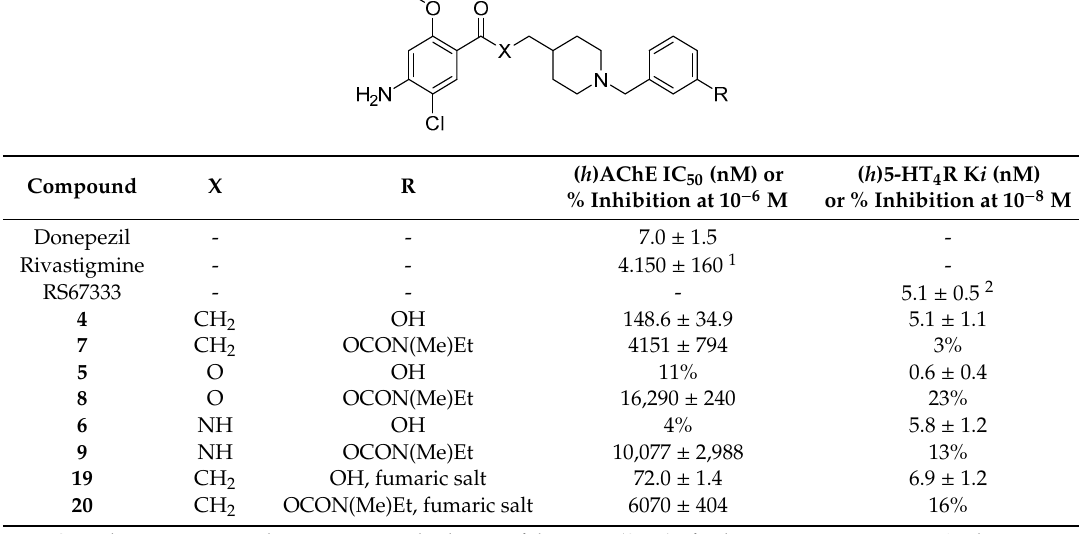
IC 50 values are expressed as mean ± standard error of the mean (SEM) of at least two experiments; K i values are expressed as mean ± standard error of the mean (SEM) of at least three experiments; 1 Data from ref. [16]; 2 Data from ref. [17].